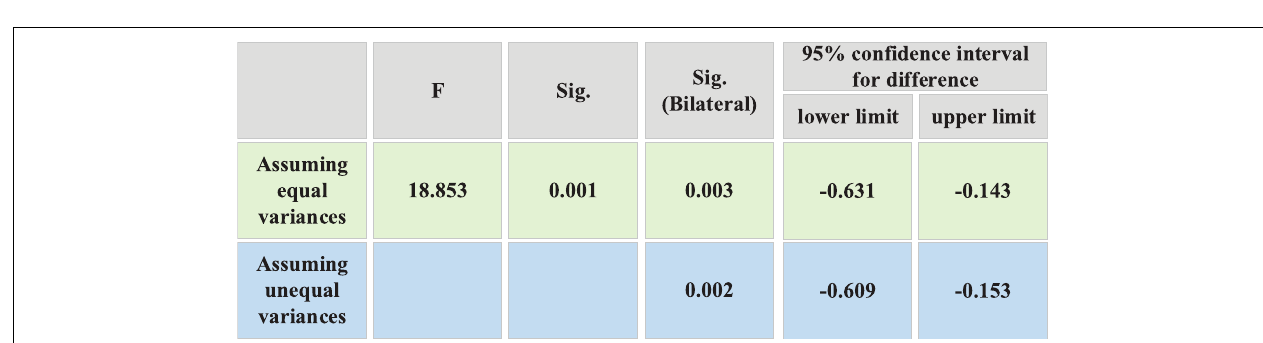
FIGURE 4 | Gender differences in whether students consider starting their own businesses in their major.